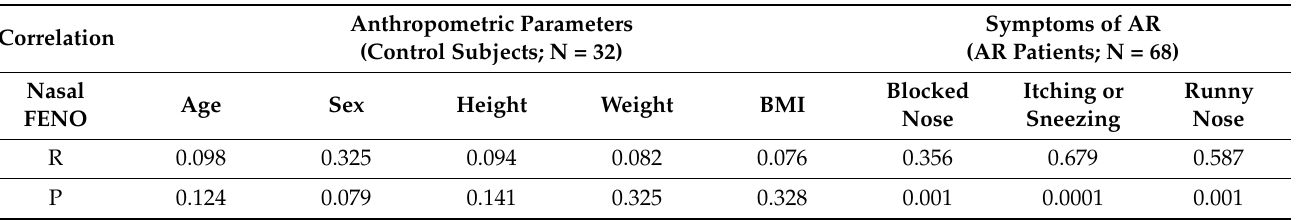
Table 2. Correlation between nasal FENO and the anthropometric characteristics of the control subjects and with clinical symptoms in patients with AR.